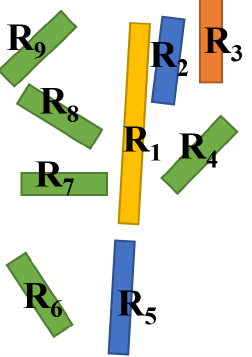
Figure 10. The final segmentation results of power lines.